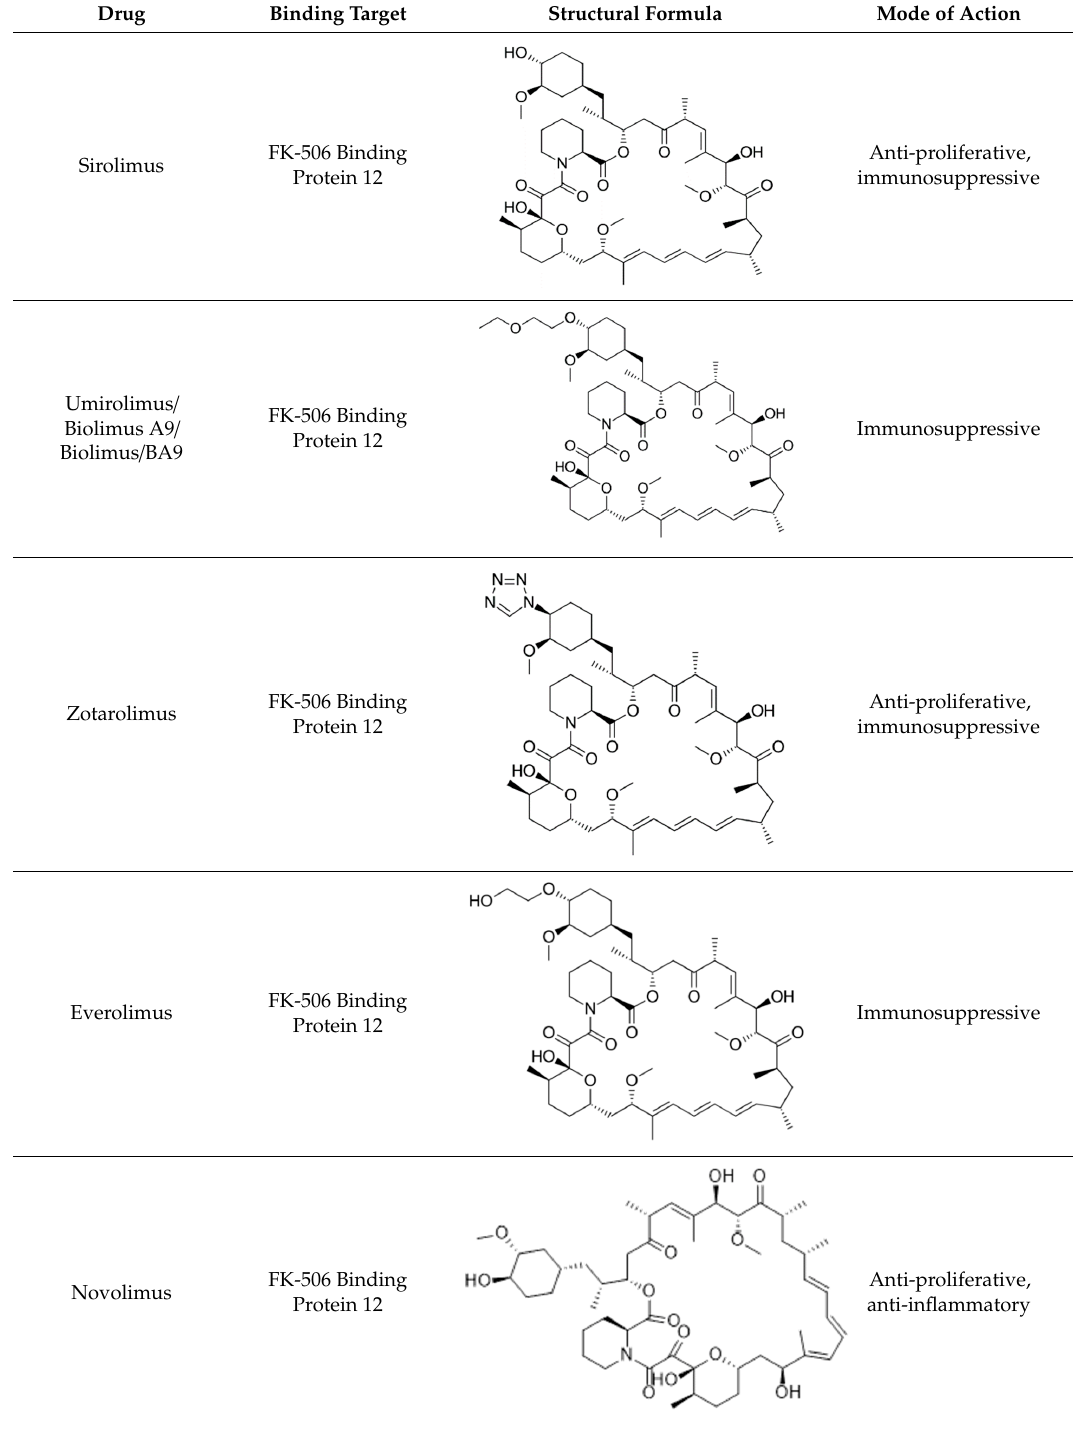
Table 6. Drugs commonly used in DES.